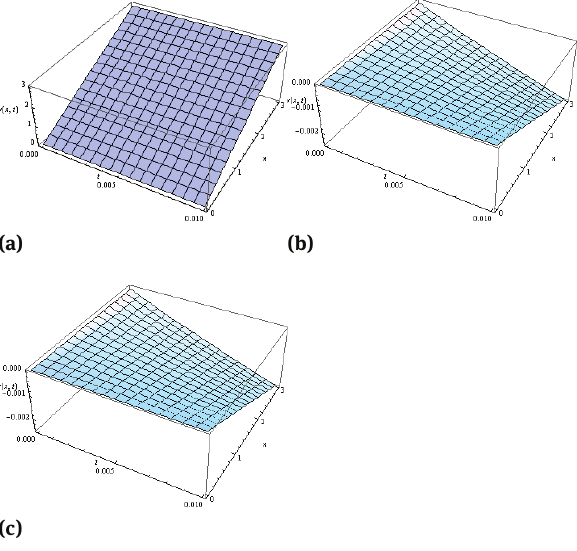
Fig. 3: v ( x , t ) obtained by (a) FDTM, (b) MFDTM and (c) Solution in [35] when α = 0.9 , r = 0.25 , τ = 0.2 , A = 1 and B = 10